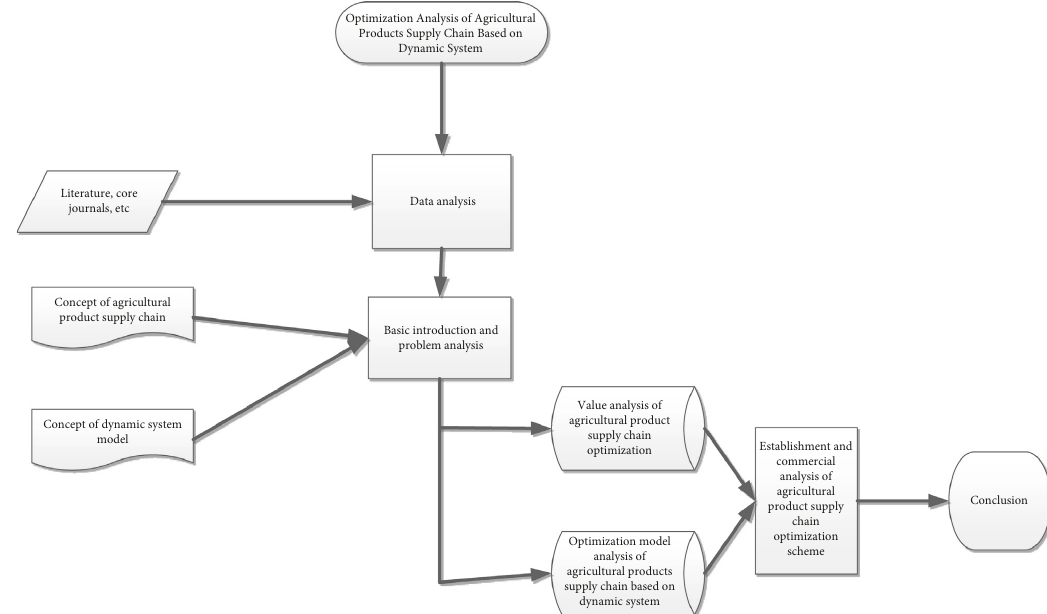
Figure 4: Technical route analysis diagram.